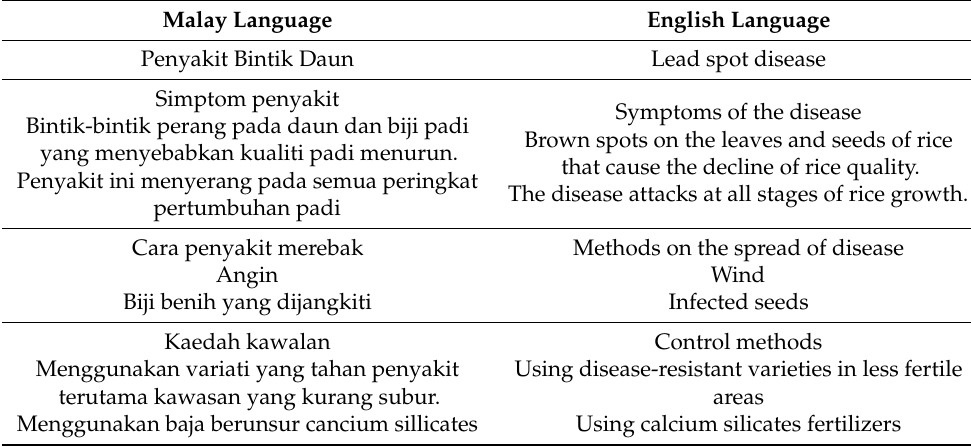
Table 2. English translation of sentences in the mobile applications. Malay Language